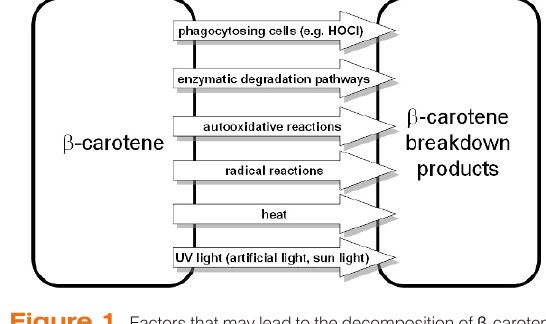
Figure 1. Factors that may lead to the decomposition of β -carotene and the formation of potentially-toxic breakdown products.